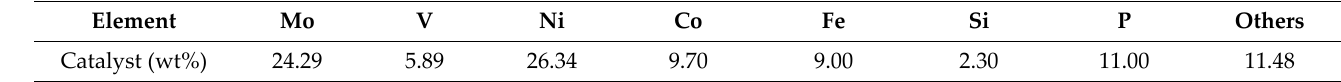
Table 1. Chemical composition of the waste HDS catalyst used in this work.